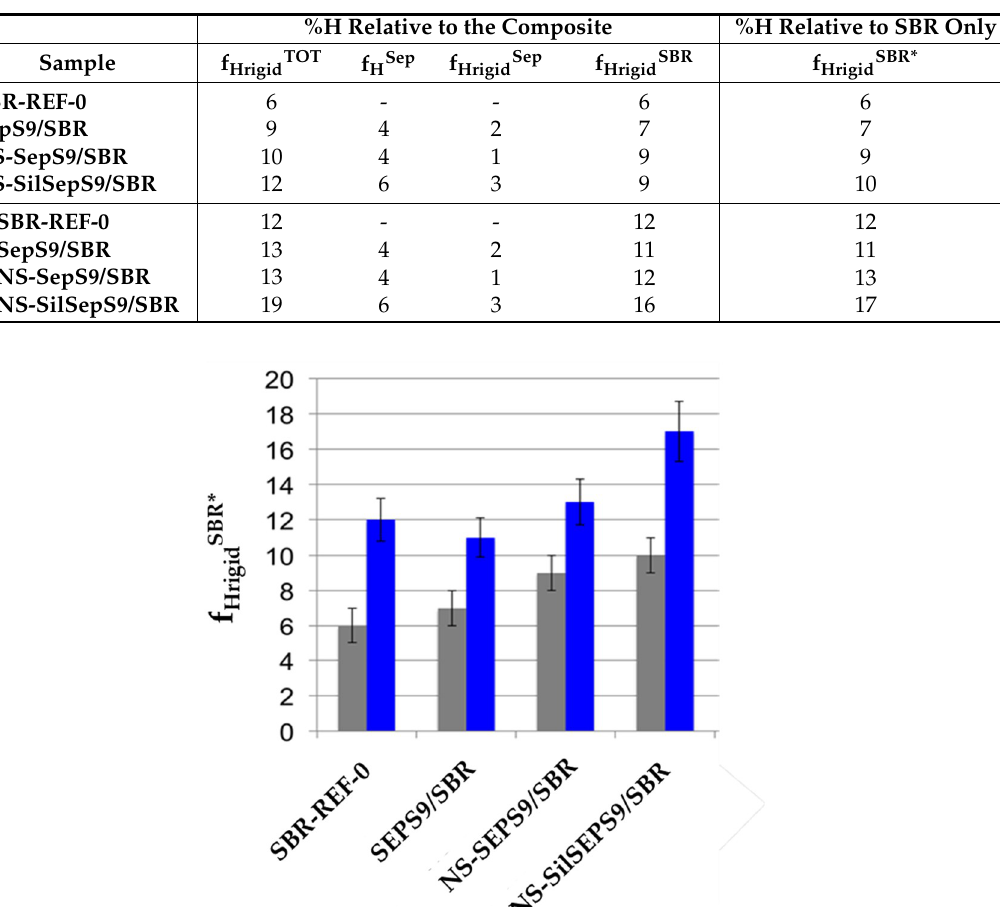
Table 2. Molar percentages (%H) of 1 H nuclei belonging to the filler (f HSep ) and of 1 H nuclei in rigid environments, as determined by FID analysis using the procedure described in the text. f HrigidTOT is the total fraction of protons in rigid environments, while f HrigidSep and f HrigidSBR are the fractions of filler and rubber protons in rigid environments, relative to the whole composite, respectively. f HrigidSBR* is the fraction of rubber protons in rigid environments relative to the sole SBR component.